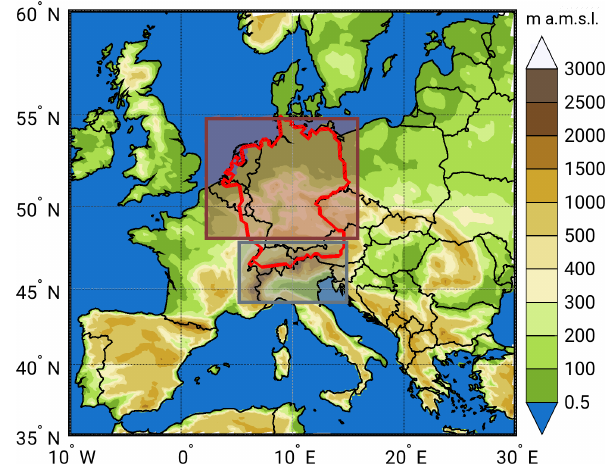
Figure 1. Topographic map of Europe at model resolution 0.22 ◦ (in meters above mean sea level; ma.m.s.l.) with the PRUDENCE regions Mid-Europe (ME; dark red box) and the Alps (AL; gray box), state borders (black contours), and the HYRAS area (light red contour). Ocean grid cells are set to a missing